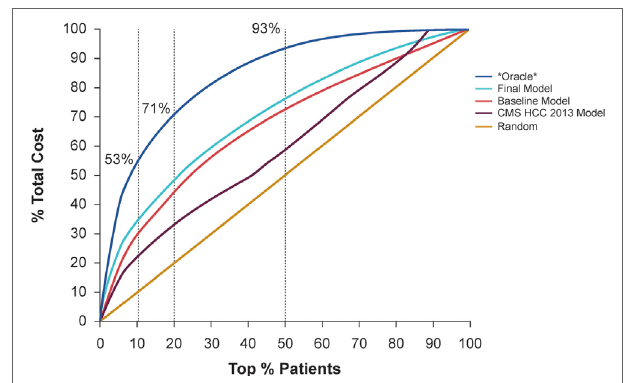
FigUre 3 | Demonstration of the cost captured by the baseline model and final model with different top % patient ranks, compared to random selection and *Oracle* selection that can predict the future with 100% accuracy.